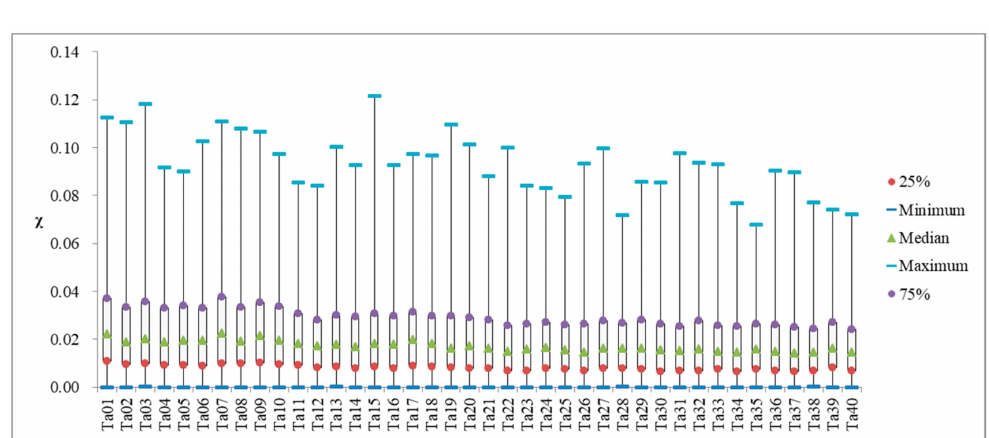
Figure 5. The quartile graph of the absolute relative deviation χ ( ∆ a c , ∆ sim c ) in the problem set